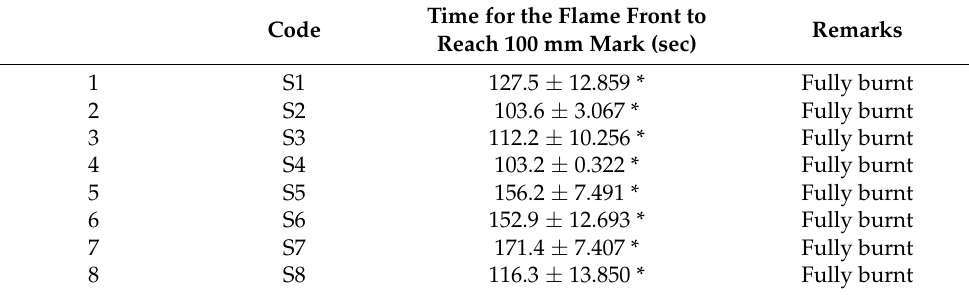
Table 5. The UL94 combustibility properties of the laminated composites. Time for the Flame Front to Code Reach 100 mm Mark